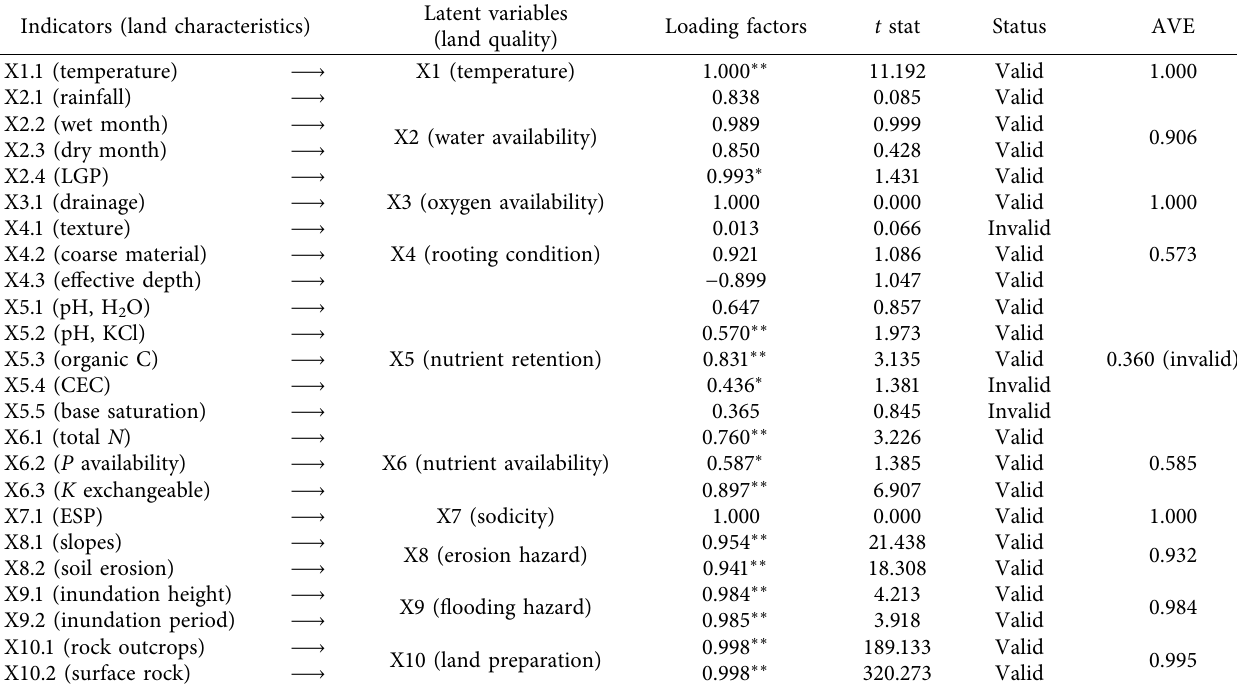
Table 3: Outer loading (loading factor) and the average variance extracted from study variables.